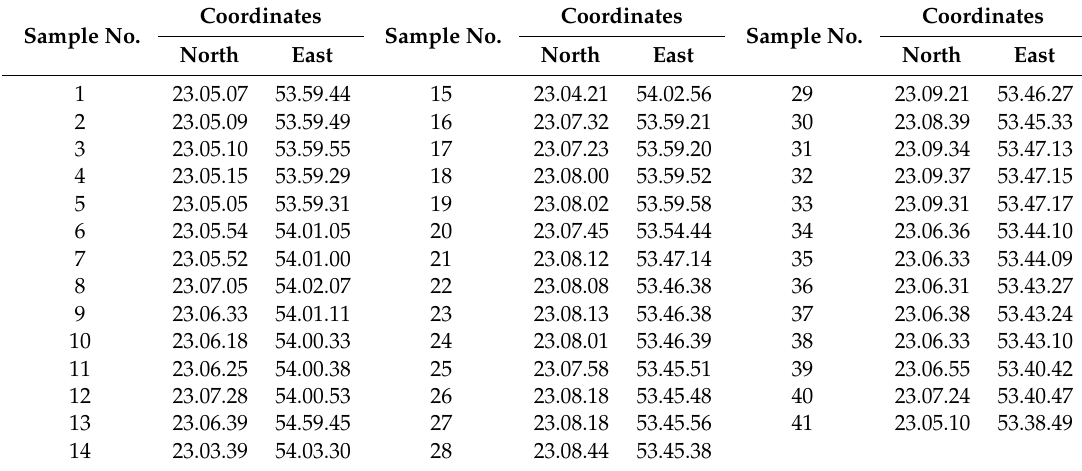
Table 1. Coordinates of the drilling